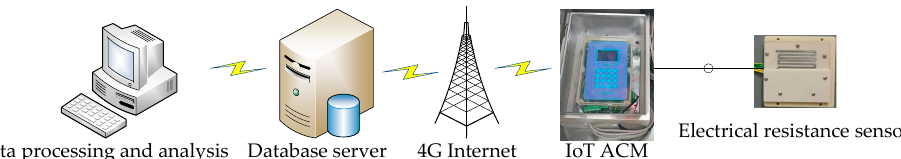
Figure 1. The schematic illustration of performance analysis experiment. IoT ACM, Internet of Things atmospheric corrosion monitor.